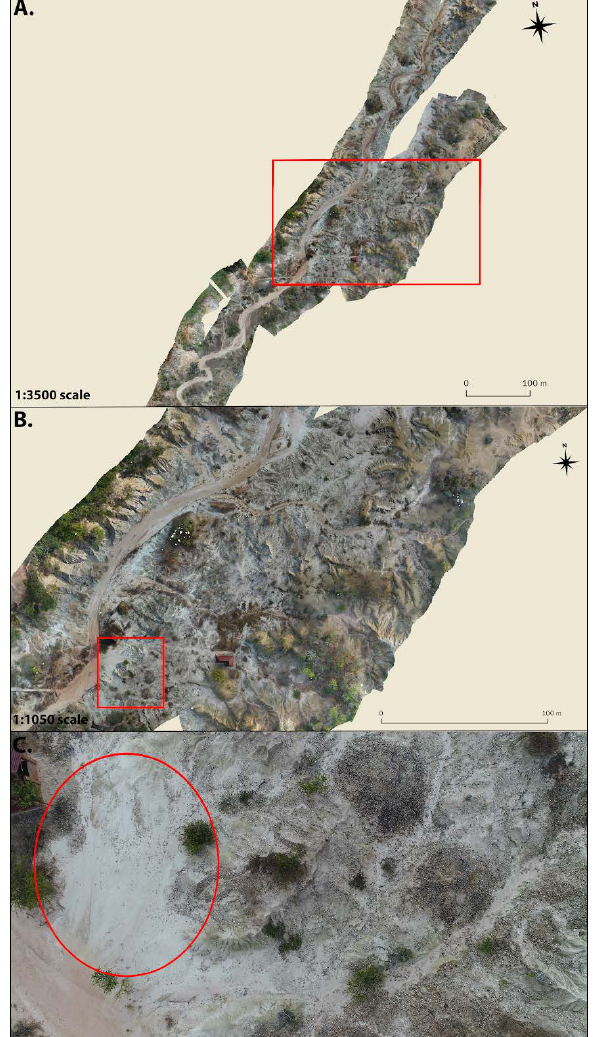
Figure 10: (a) Location within the northern branch of the Howell et al. 4 H20 trenches, outlined in red. (b) Inset of the H20 trenches, outlined in red. (c) Detail of the former site of extensive excavations at the H20 trenches, circled in red. The small structure in the top left corner once contained a partial skeleton of a hippopotamus unearthed in one of the